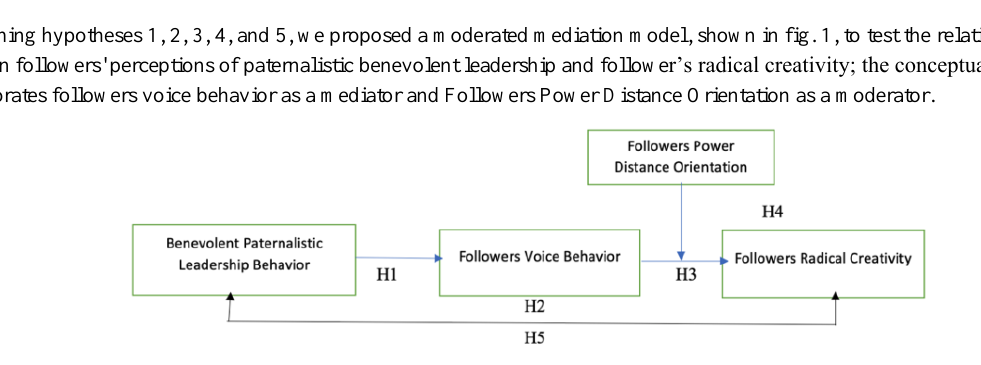
Figure 1: Hypothesized and conceptual framework model. All hypothesized variables relationships are positively shown. H hypothesis , H1/H3 represents direct and indirect effect . H2 represents mediational effect, H4 represents the moderation